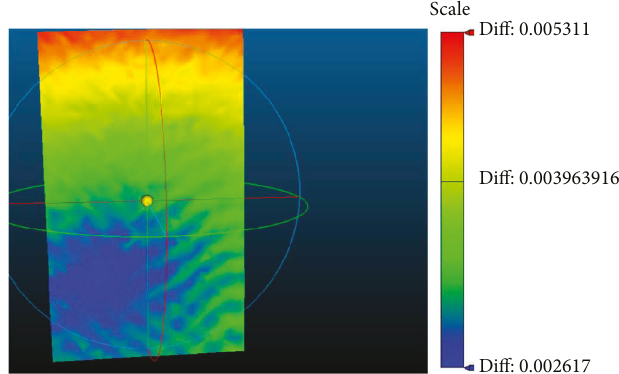
Figure 20: The result of the di ff erence map with a 1.2mm movement of the top of the plate (and a movement of about 0.3mm of the lower part of the plate). This result demonstrates the ability of the algorithm to compute a smooth and continuance di ff erence